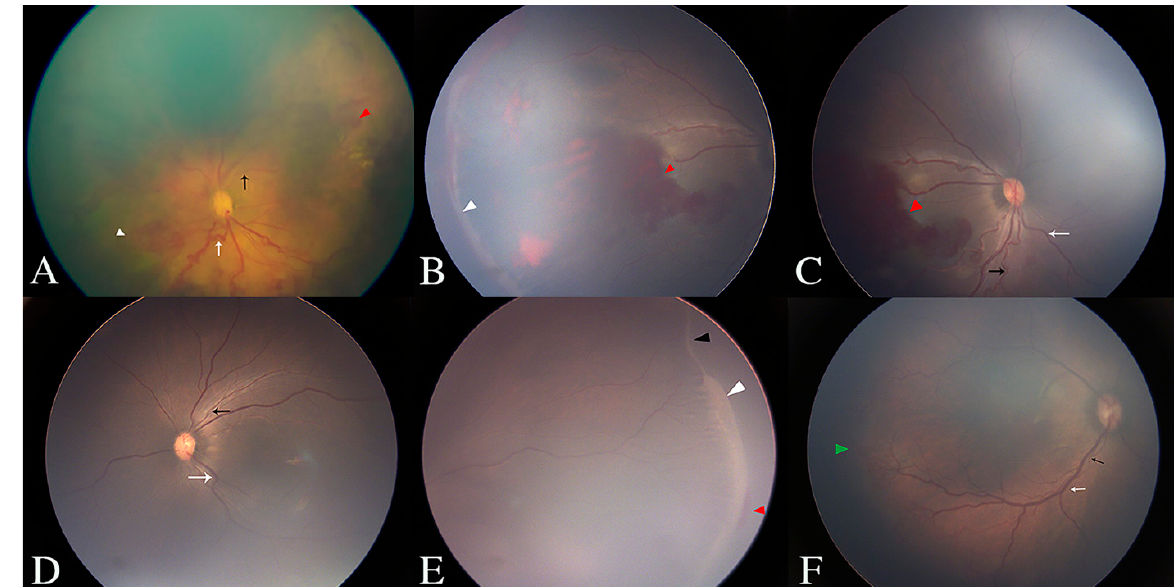
Figure 1. Fundus photographs demonstrating the results of the fundus examinations, including the vessel tortuosity in zone I, and the location and stage of ROP lesions. ( A ) Female, GA 33 W + 6, BW 1900 g, PMA 38 W, right eye, A ‐ ROP with zone I stage 3 disease (white arrowhead) and intraretinal hemorrhage (red arrowhead). Artery and venous tortuosity were graded as mild (black arrow) and severe (white arrow), respectively. ( B ) and ( C ) Male, GA 30 W + 4, BW 1500 g, PMA 41 W + 2, right eye, T ‐ ROP with anterior zone II stage 3 disease (white arrowhead) and intraretinal hemorrhage (red arrowhead). Artery and venous tortuosity were graded as severe (black arrow) and mild (white arrow), respectively. ( D ) and ( E ) Male, GA 30 W + 4, BW 1500 g, PMA 41 W + 2, left eye, P ‐ T ‐ 1 with anterior zone II stage 3 disease (white arrowhead) and intraretinal hemorrhage (red arrowhead). Artery and venous tortuosity were graded as mild (black arrow) and moderate (white arrow), respectively. Stage 2 disease (black arrowhead) was also presented in this eye. ( F ) Male, GA 30 W + 5, BW 1700 g, PMA 36 W + 6, right eye, P ‐ T ‐ 1 with posterior zone II stage 1 disease (green arrowhead). Artery (black arrow) and venous (white arrow) tortuosity were both graded as moderate.